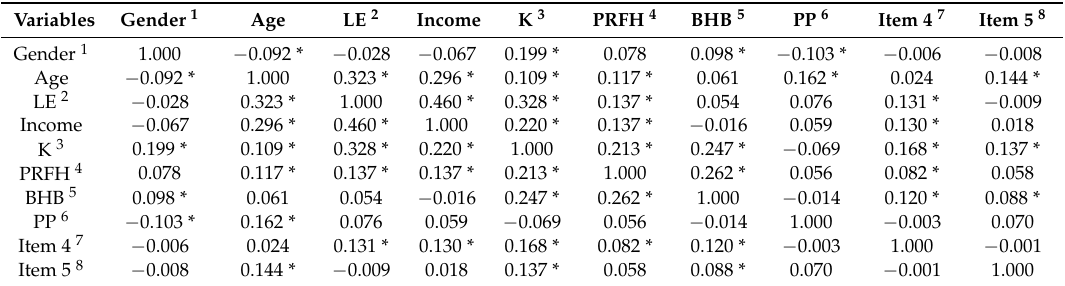
1 Gender: Male = 1, Female = 2; 2 LE: Level Education, 3 K: Knowledge, 4 PRFH: Perception of the role of food for health; 5 BHB: Belief in health benefits; 6 PP: Perception of the price; 7 Acceptance: If they taste good; 8 Acceptance: If they taste worse than their conventional counterpart foods; * Significant correlation ( p <